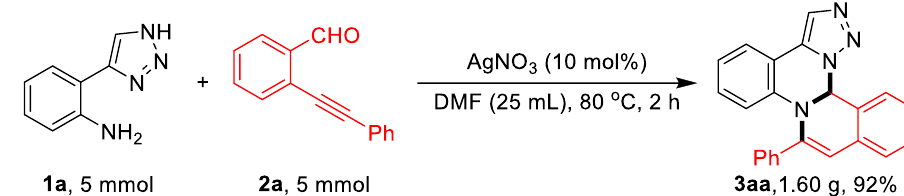
Figure 3. Scope of 2-(1 H -1,2,3-triazol-5-yl)aniline . Reaction conditions: 1a (0.2 mmol), 2 (0.2 AgNO 3 (10 mol%) in DMF (1 mL) at 80 ◦ C for 2 h. Isolated yield. mmol), AgNO 3 (10 mol%) in DMF (1 mL) at 80 °C for 2 h. Isolated yield.